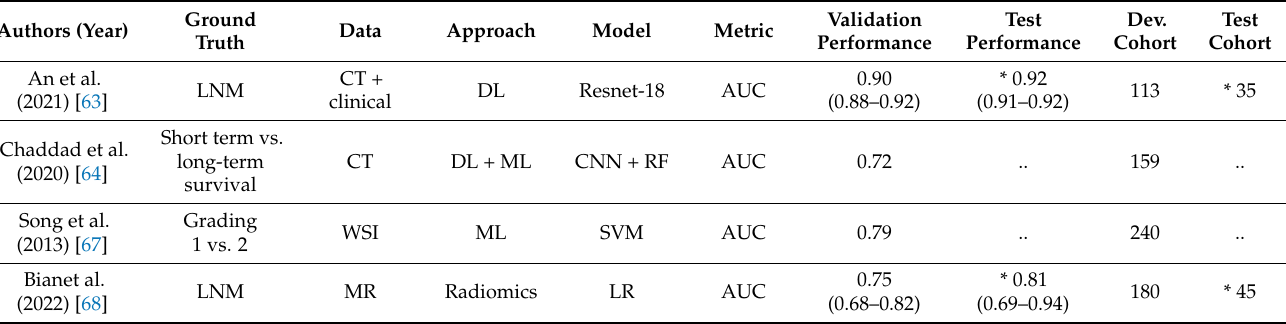
Table 3. Summary of papers on AI for stratification of PDAC patients. The performance for the validation and test sets is reported with respective 95% Confidence Interval or standard deviation when it was